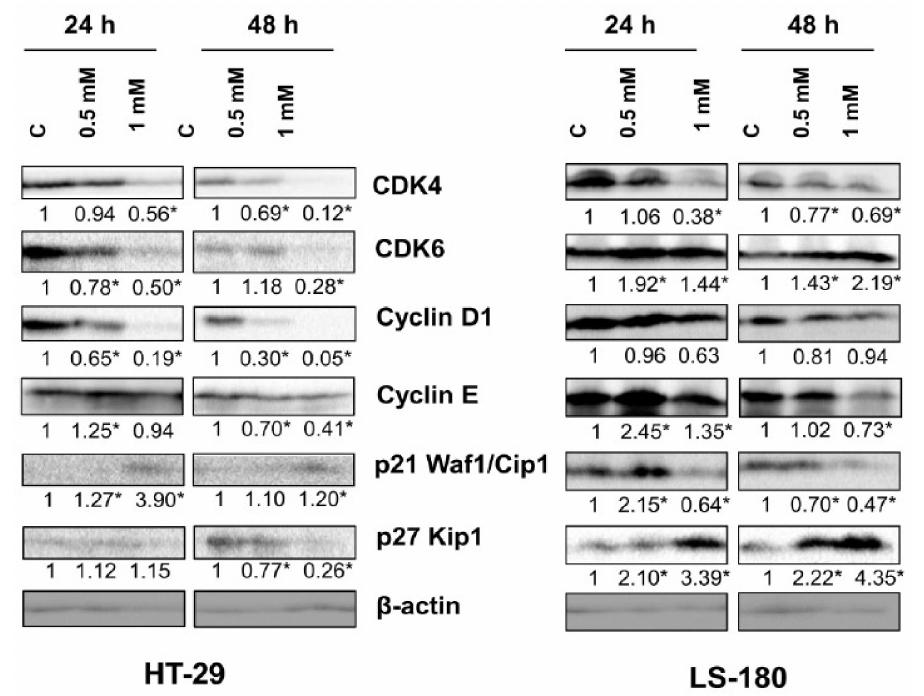
Figure 5. The e ff ect of 8-hydroxyquinaldic acid on protein expression of selected cell cycle regulators in human colon adenocarcinoma cells. Western blot analysis of selected cell cycle regulators was performed after treatment of HT-29 and LS-180 cells with 8-hydroxyquinaldic acid (0.5, 1 mM) for 24 and 48 h (C control, not treated). Western blots shown in the figure were selected as the most representative of the series of repetitions n ≥ 3. The data were normalized to β -actin and calculated fold changes in protein expression marked (fold changes ≥ 0.20 were considered as significant [*]).